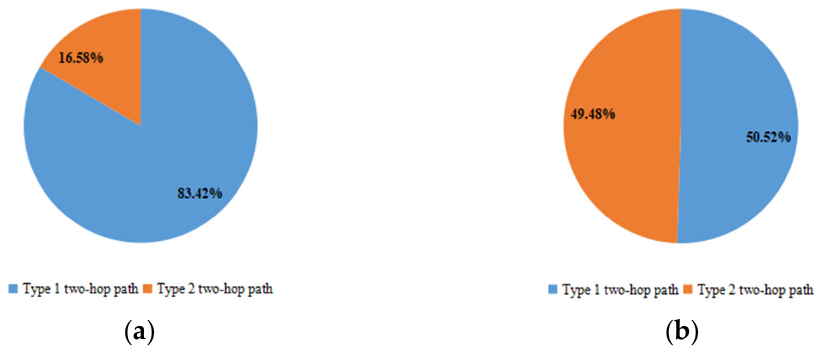
Figure 7. The evaluation of subsystem 1, subsystem 2 and path fusion with/without the relation score. ( a ) is the result of subsystem 1; ( b ) is the result of subsystem 2; ( c ) is the result of the path fusion. Therefore, we analyzed the types of prediction paths of subsystem 2, and Figure 8 shows the difference in the proportion of each type in all predicted paths.